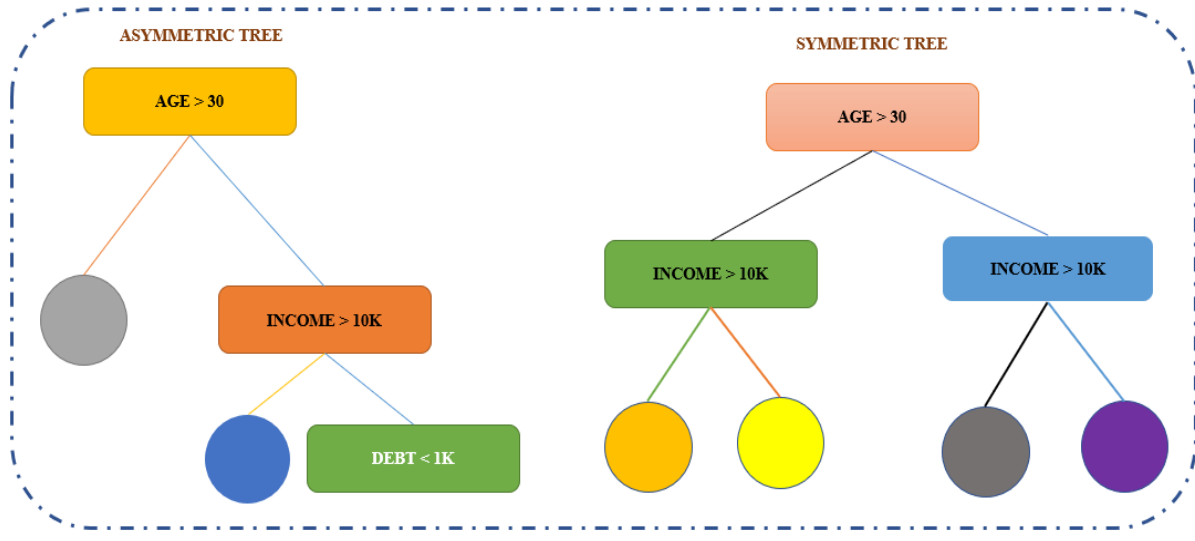
Figure 9. Catboost Symmetric Tree.